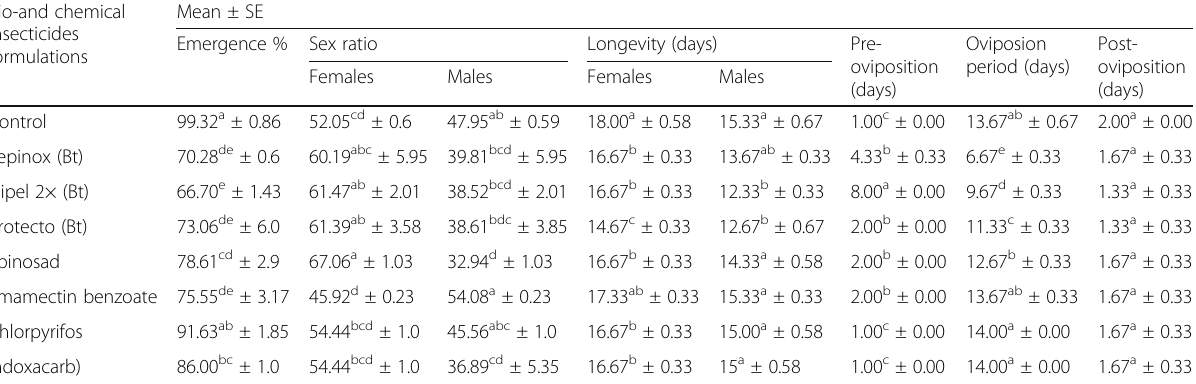
Table 4 Effects of tested bio-and chemical insecticides on the adult stage of .Tuta absoluta results from treated the 2nd instar larvae with the sub-lethal concentration of LC 30 value Bio-and chemical insecticides